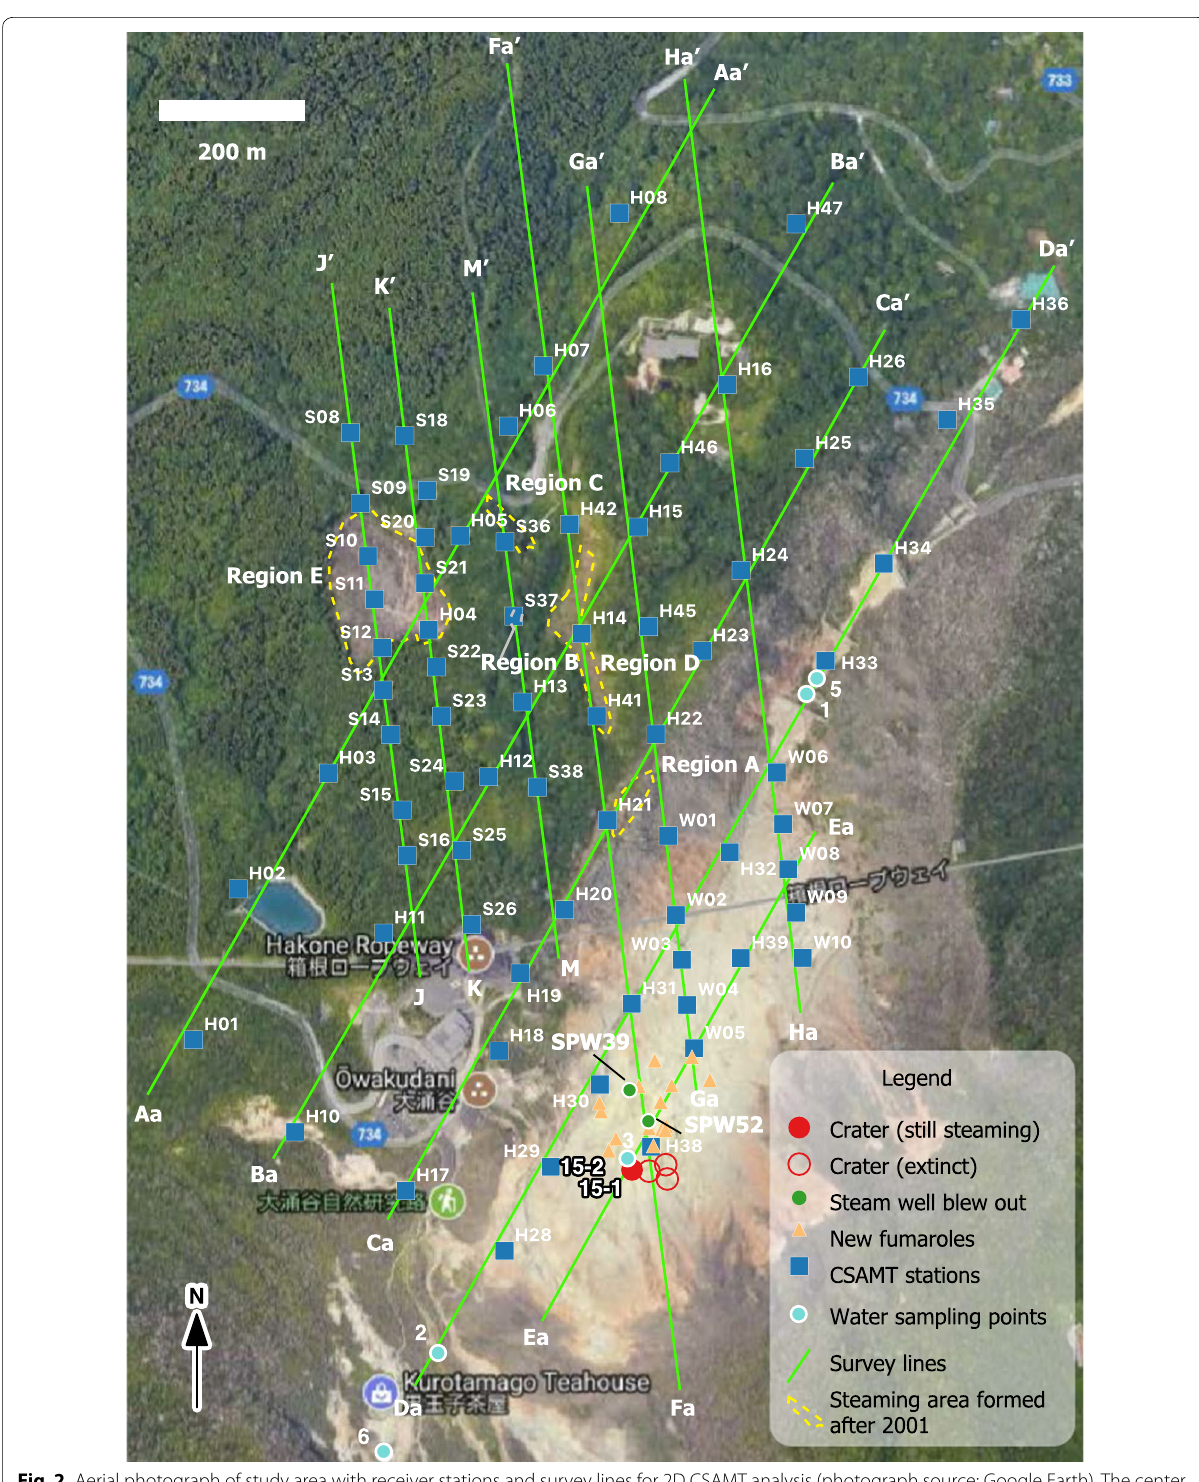
Fig. 2 Aerial photograph of study area with receiver stations and survey lines for 2D CSAMT analysis (photograph source: Google Earth). The center of the 2015 eruption is in the lower center of the map, and the craters and fumaroles formed by the eruption are shown. The locations of the steam production wells that blew out during the precursory unrest of the 2015 eruption and areas of newly formed fumaroles after 2001 are also